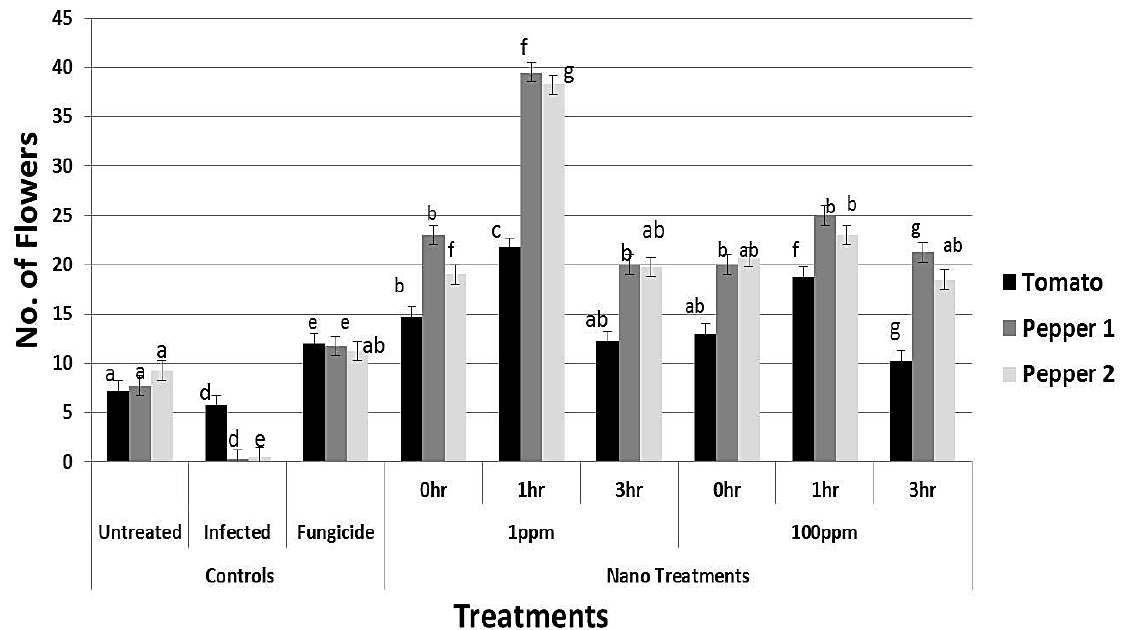
Figure 9. Effect of rGO-CuO NP treatments, as indicated, on flower increment in tomato and pepper plants (nine biological replicates). Two independent experiments with pepper plants are plotted. Letters on bars mean statistically significant differences between the mean of the respective control and the nanocomposite at the same concentration ( p < 0.05).